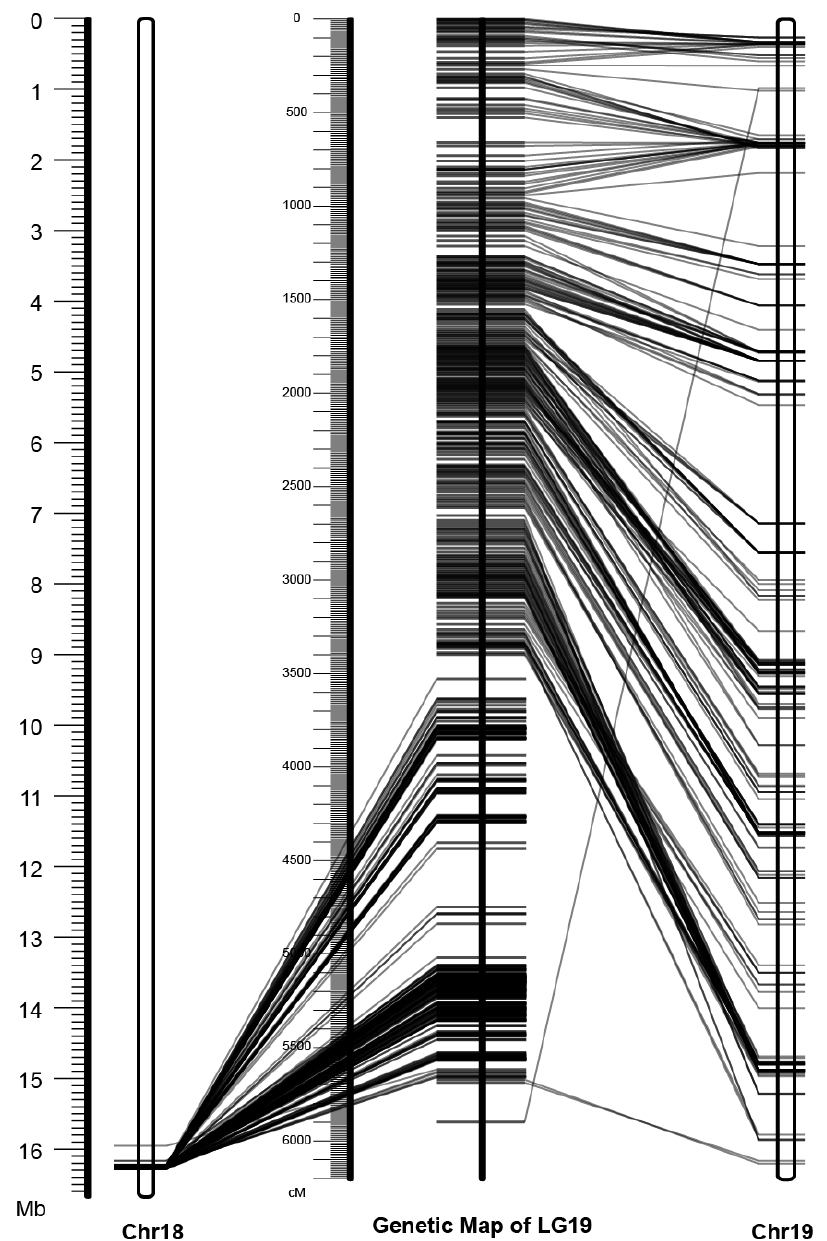
Figure 2. Comparison between the genetic map of chromosome 19 and the physical assemblies of chromosomes 18 and 19 in Stettler-14 V1. The physical assemblies of chromosomes 18 and 19 are on each side with unfilled rectangles, and the built genetic map of chromosome 19 is shown in the middle. Each horizontal tick represents a genetic marker and the corresponding physical position and genetic positions are connected with a line.